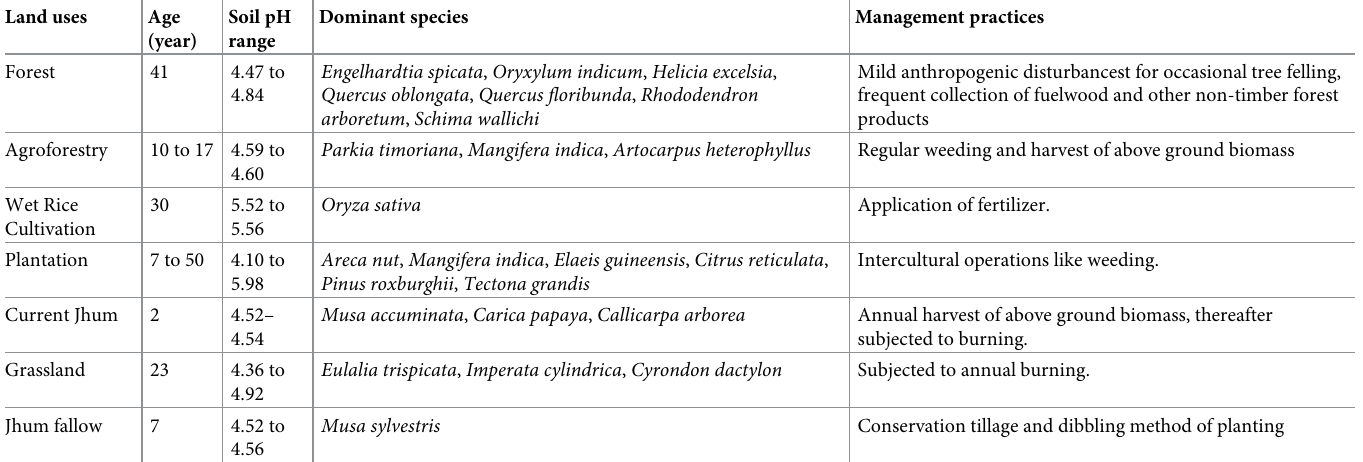
Table 1. Soil characteristics and management practices of different land